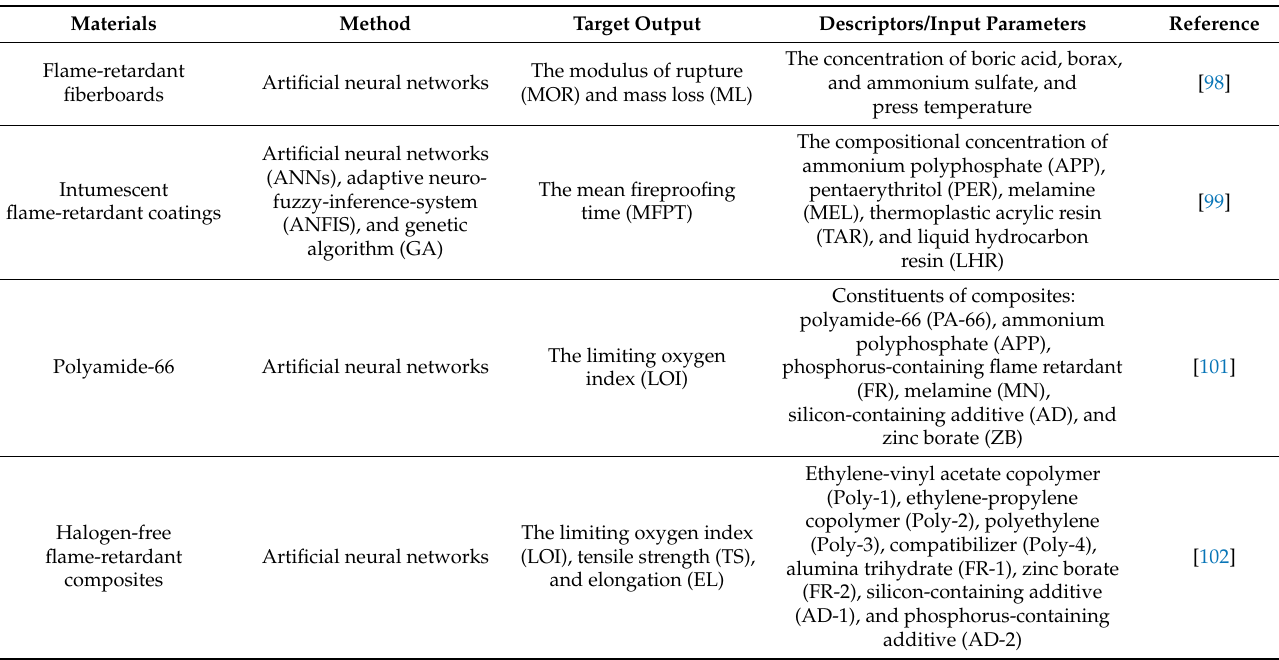
Table 7. Typical descriptors used in AI/ML models to predict the fire performance of flame-retardant